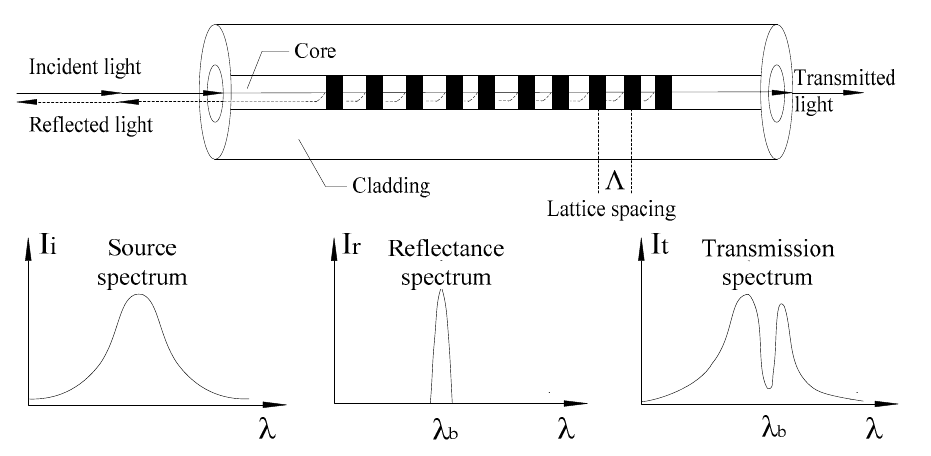
Figure 7. Photo of sensitized miniature FBG strain sensor.